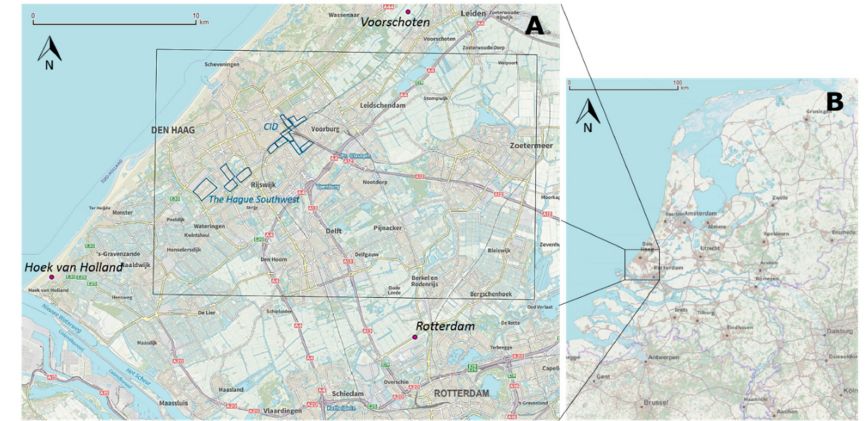
Figure 1. The agglomeration of The Hague (panel A ) and an overview map of the Netherlands (panel B ) [28]. The black rectangle in panel A indicates the study area for which the heat map was calculated. The three WMO stations are indicated in italics (Voorschoten, Hoek van Holland, and Rotterdam). Rotterdam acts as a rural reference station. The blue shapes in The Hague (Den Haag) represent the urban districts, Central Innovation District (CID), and The Hague Southwest, for which different urban planning strategies were evaluated for heat